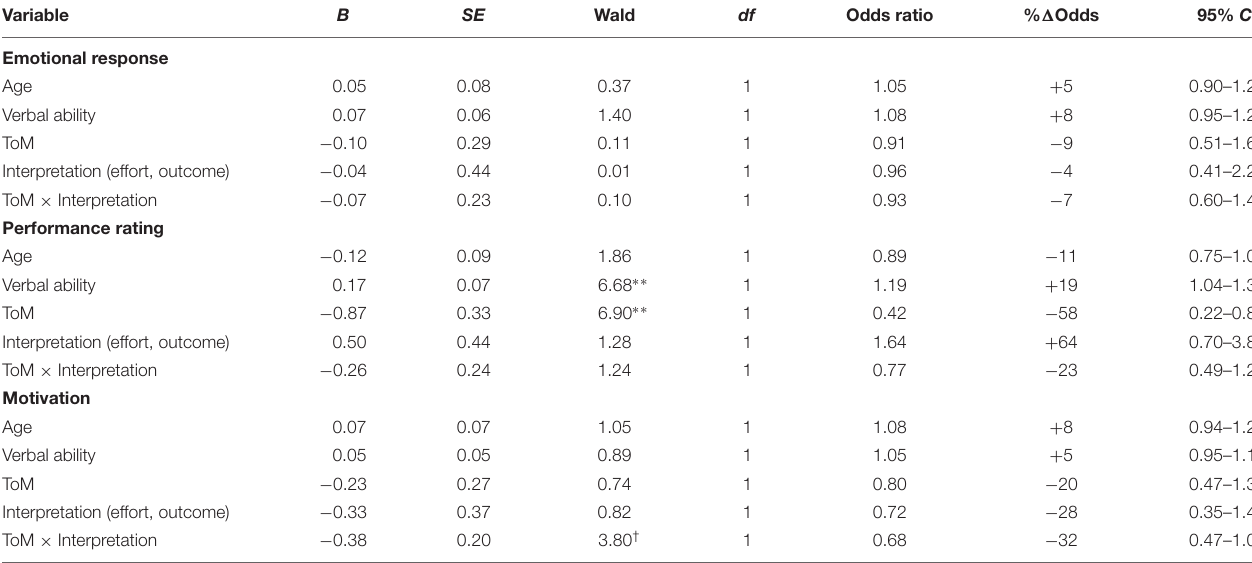
TABLE 2 | Results of the logistic regression analysis (final